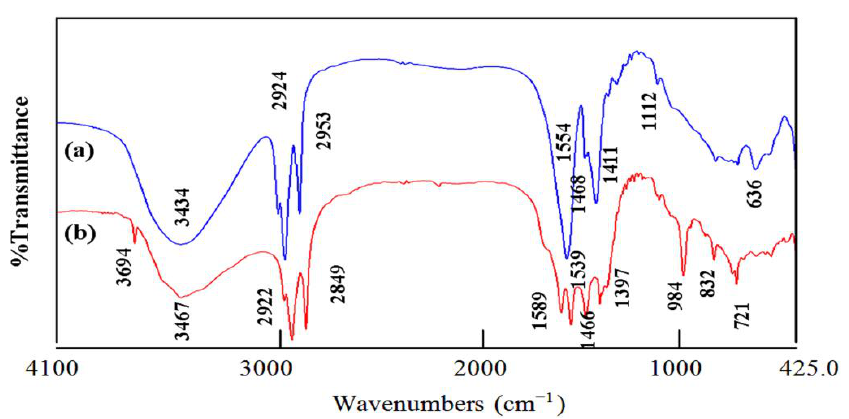
Figure 5. FT-IR spectra of: ( a ) the nanohybrid NHZ-1 and ( b ) the nanohybrid NHZ-2.